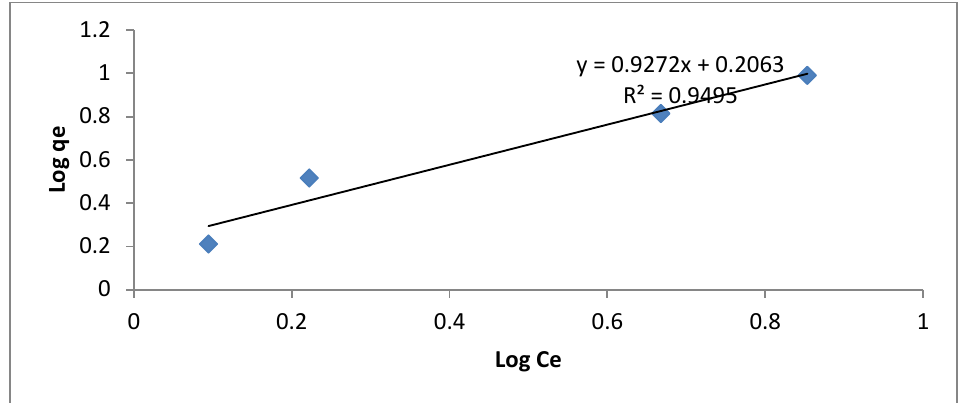
Figure 7: Langmuir isotherm for Chromium removal by unripe banana peel biomass